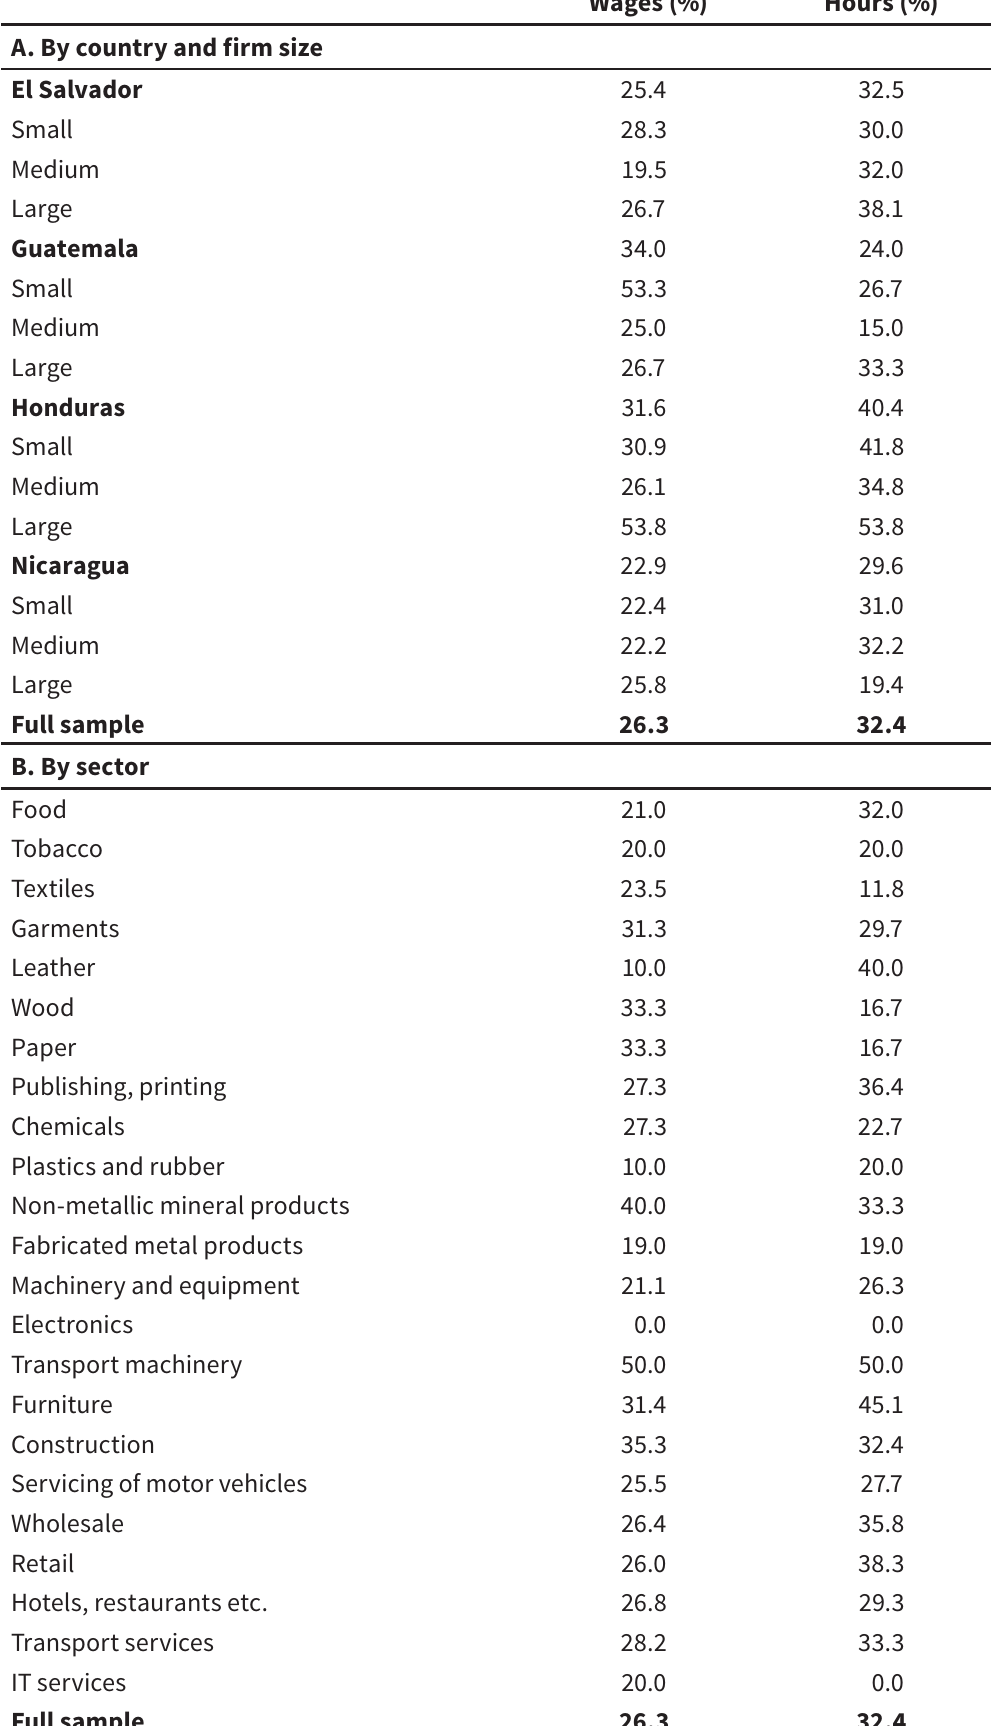
Proportion of responding firms who cut wages or hours for at least some workers Wages (%) Hours